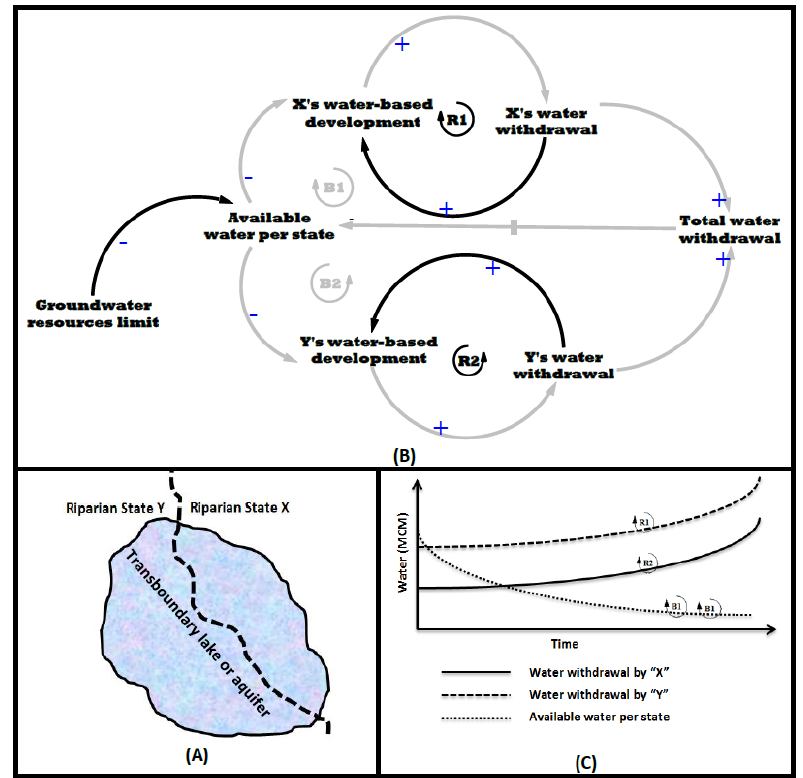
Figure 5. ( A ) The schematic of the physical environment that can embrace HSA5 (real cases